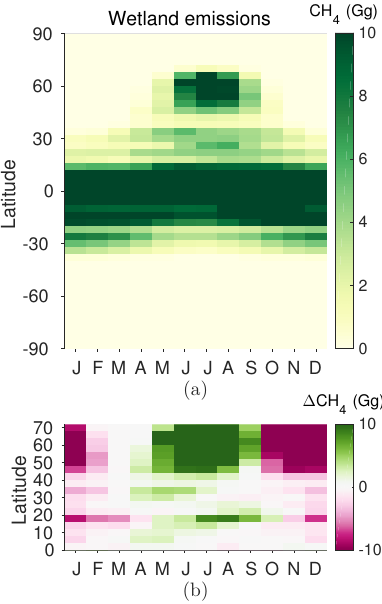
Figure 10. (a) GEOS-Chem monthly zonal mean wetland emis- sions, in Gg. (b) The Northern Hemisphere sensitivity of GEOS- Chem wetland emission attribution caused by a 3-month lag for each 1ppb increase of CH 4 in the tropospheric column, in